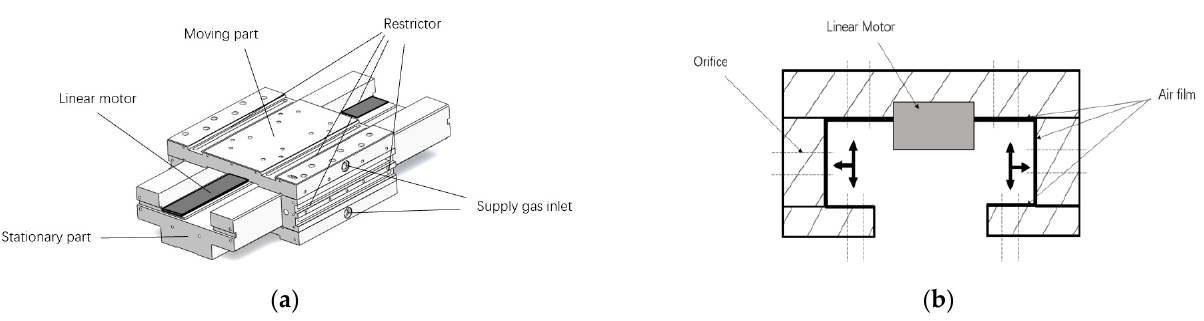
Figure 1. The aerostatic bearing slideway designed: ( a ) key components; ( b ) Schematic illustration.